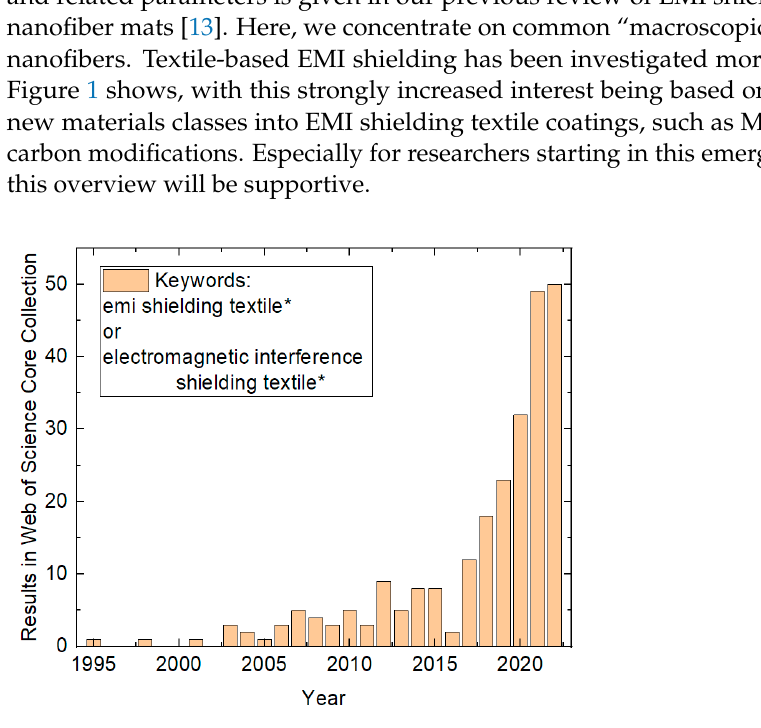
Figure 1. Numbers of results in the Web of Science Core Collection for the keywords given in the inset, counted on 12 January 2023.